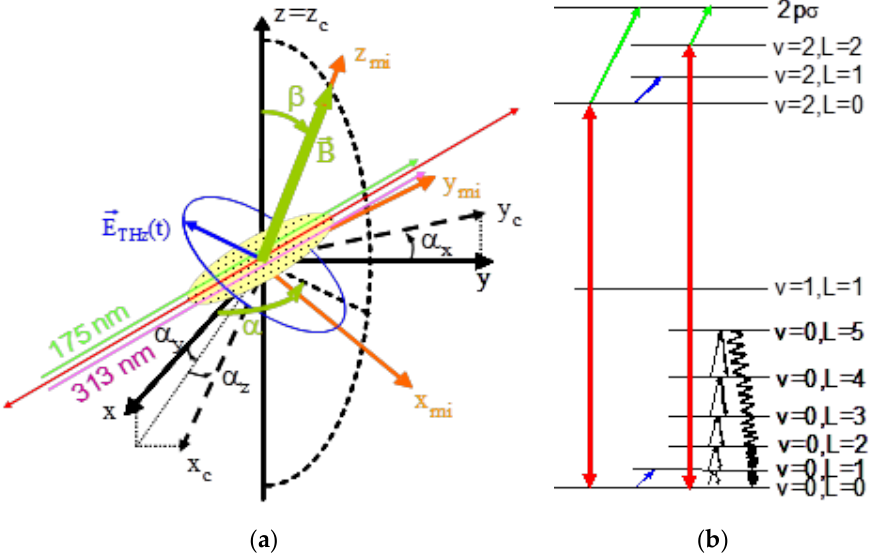
Figure 1. ( a ) The experimental setup and the reference coordinate frames. The THz electric field (blue polarization ellipse) is off-resonantly coupled to the energy levels of the HD + ions embedded in a Coulomb crystal (yellow). Two-photon spectroscopy is performed with a stationary wave from the IR laser (red line). Be + ions are cooled with the 313 nm laser (magenta line). The detection is performed by dissociating HD + ions with the 175 nm laser (green line). The static magnetic field in the ion trap (olive line) can be oriented to any direction, which is defined with the Euler angles ( α , β ) in the Cartesian Laboratory Coordinate Frame (x, y, z) (black lines) ( LCF ). The orientation of the coil pairs defines the Coil Coordinate Frame (x c , y c , z c ) (dotted black lines) ( CCF ), with the nonorthogonality angles ( α x , α y , α z ) relative to the laboratory frame. The standard components of the THz wave are referenced to the Cartesian Molecular Ion Coordinate Frame (x mi ,y mi ,z mi ) (orange lines) ( MICF ) and related to the laboratory frame through a z–y–z rotation with the Euler angles ( α , β , χ = 0). ( b ) Rotation–vibration energy levels of HD + addressed in the THz sensing scheme. The two-photon rovibrational transitions are shown with red lines with arrows, the dissociation is shown with green lines with arrows, the THz wave-driven electric dipole couplings are shown with blue lines with arrows, and the blackbody-radiation-driven transitions are shown with black lines and curves with arrows. values of the projection J z = ± J (stretched states) of the levels (v, L) = (0, 0) and (v, L) = (2, 0) are